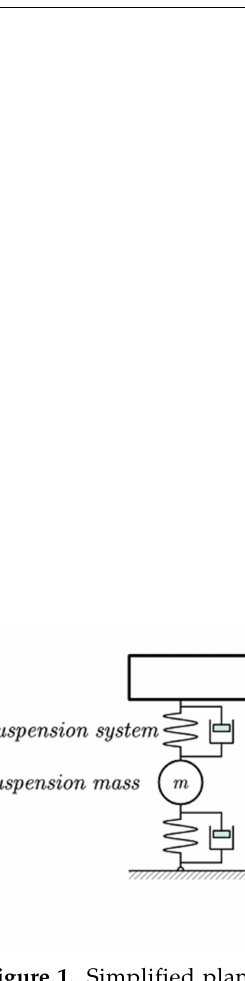
Figure 1. Simplified plane models of the vehicle: ( a ) 1/2 car model; ( b) 1/4 car model; ( c ) 1/4 car model without suspension